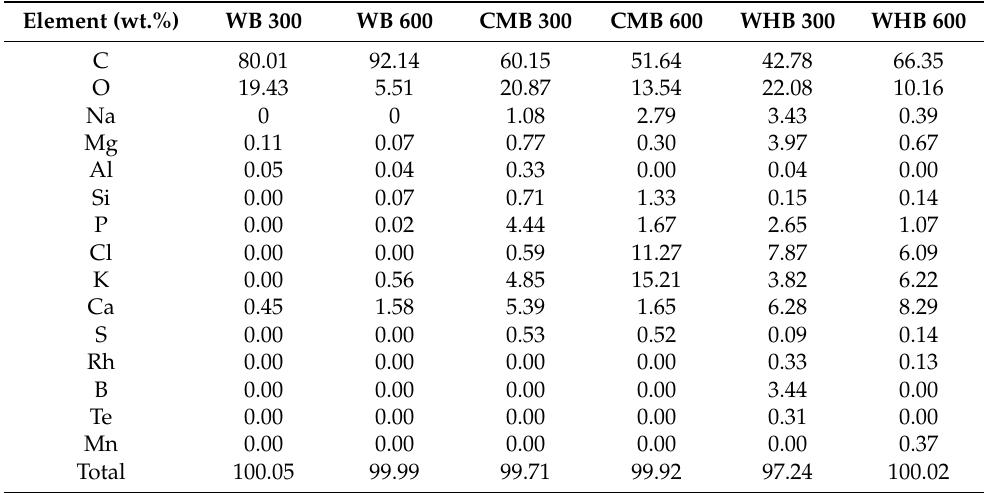
Table 2. The average percentages of elements of various biochars at different temperatures. Element